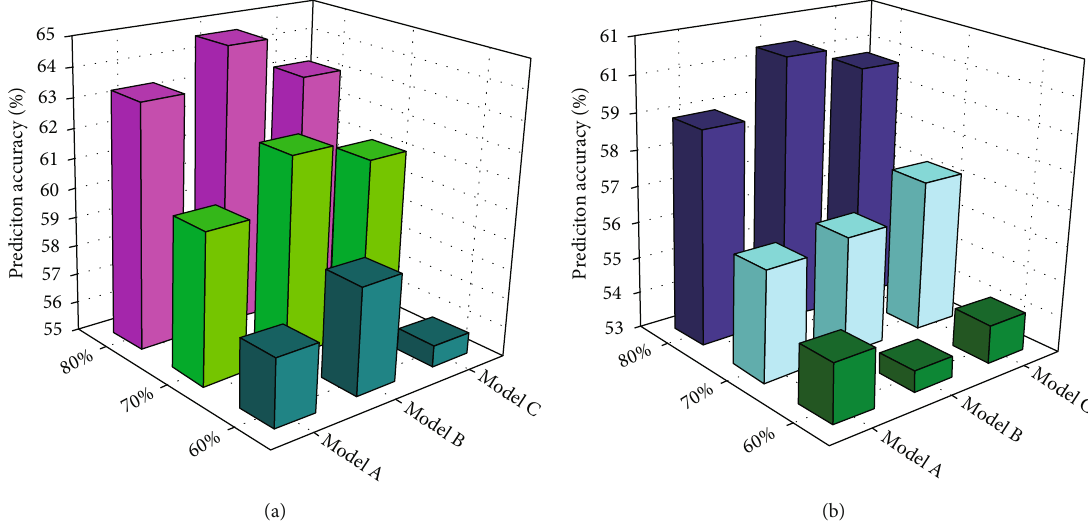
Figure 9: Comparison of prediction accuracy between the special model and the general